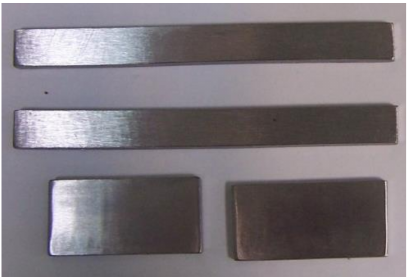
Figure 1. Coupons used for testing.